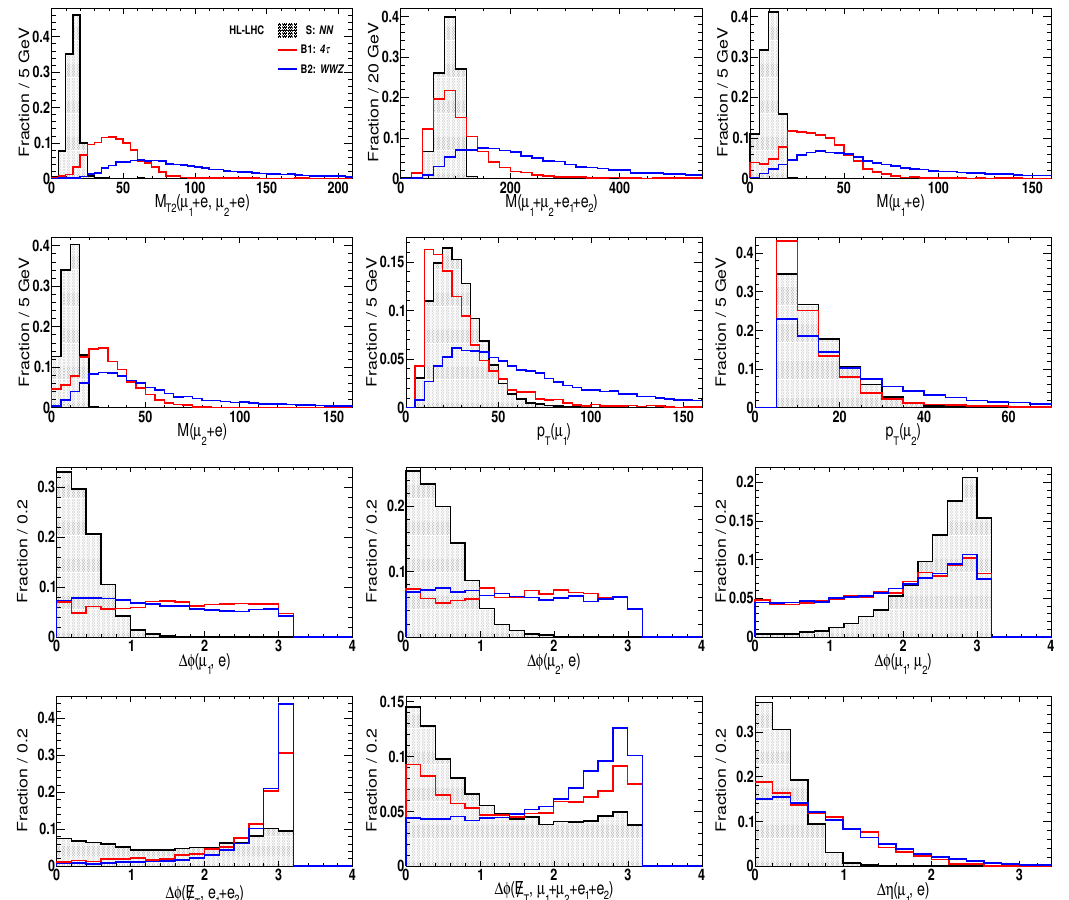
Figure 5 . Distributions of some input observables for the signal event sample (black, (cid:12)lled), and those for the SM background samples including 4 (cid:28) (red) and WWZ (blue). This plot illustrates a h 1 decay signal by gluon fusion at the HL-LHC, with m N =20